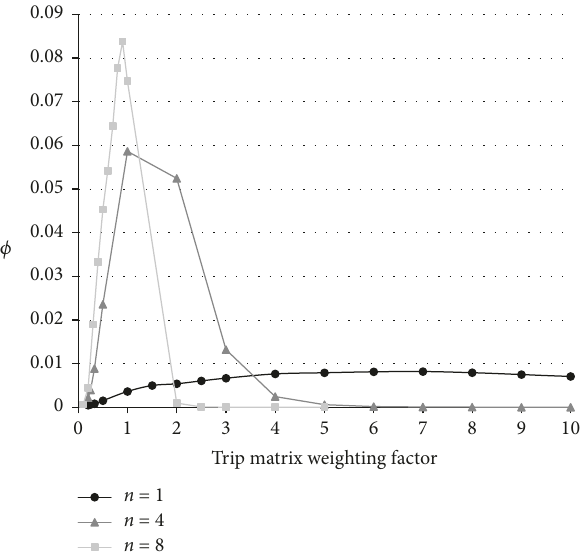
Figure 5: Relationship between 𝜙 and the demand level for the Santiago network for 𝑛 𝑎 = 1, 4, and 8.